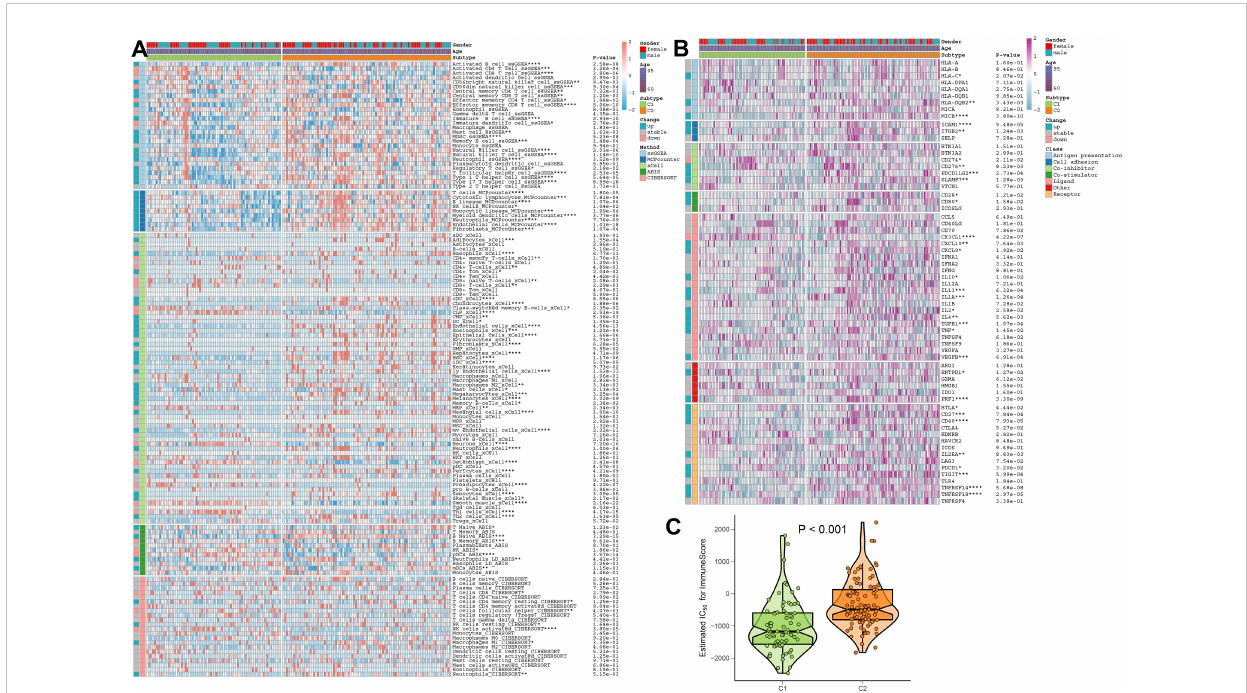
FIGURE 8 The immunological characteristics of different DDR subtypes. (A) Heatmap displaying the expression pro fi les of in fi ltrating immune cells across DDR C1 and C2 subtypes in AD patients based on the ssGSEA, MCPcounter, xCell, ABIS, and ESTIMATE algorithms. Age and gender are displayed as patient annotations. * p < 0.05, ** p < 0.01, *** p < 0.001, **** p < 0.0001. (B) Heatmap displaying the expression pro fi les of immunoregulatory subgroup genes in DDR C1 and C2 patients with AD. Age and gender are displayed as patient annotations. * p < 0.05, ** p < 0.01, *** p < 0.001, **** p